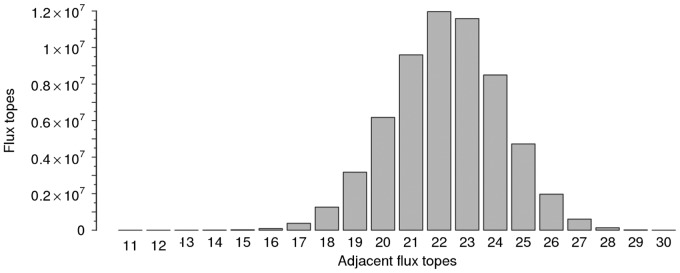
Frequency of the number of adjacent FTs, computed in iCG238